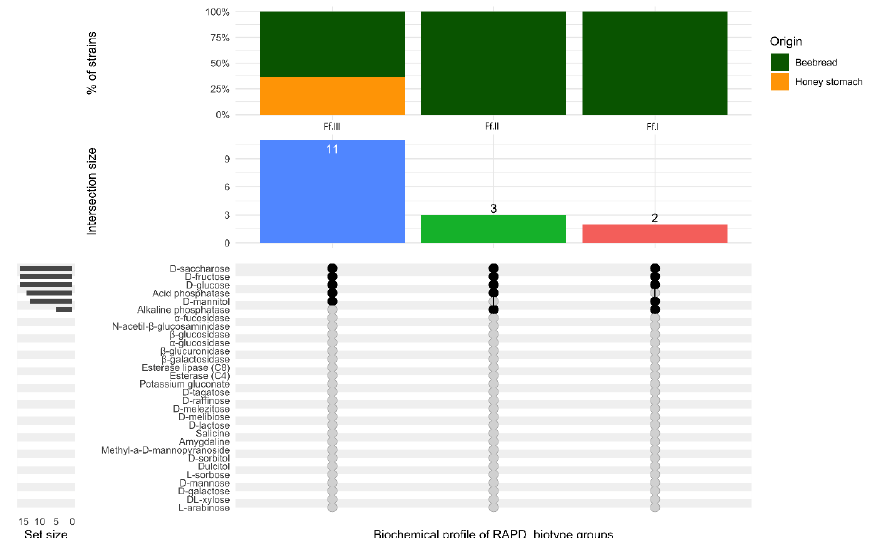
Figure 8. Upset plot regarding the biochemical profile of the 3 RAPD_biotype groups belonging to Fructobacillus fructosus . Vertical barplot indicates the number of overlapping strains (intersection size) for each intersection represented by the connected dots. The intersection matrix is sorted in descending order. The grey horizontal barplots, reported as “Set size”, indicate the number of strains showing enzymatic activity.